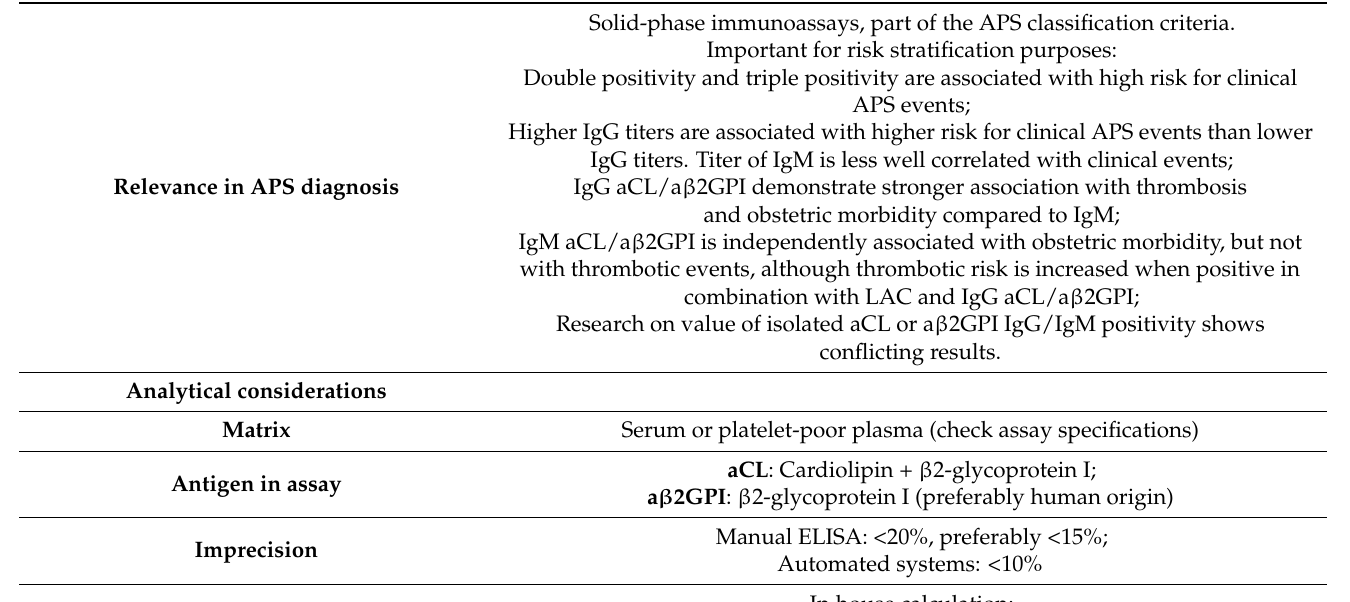
Relevance in APS diagnosis